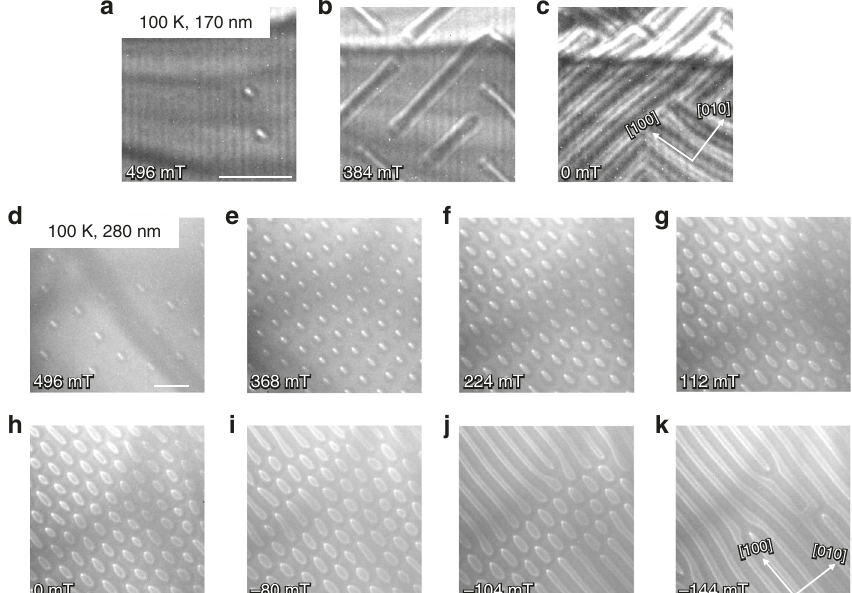
Fig. 4 Elliptical skyrmions at 100 K for two different sample thicknesses. In a – c LTEM measurements in the previously investigated sample (170 nm thick) are shown. The fi eld is reduced coming from the ferromagnetic phase, with only a few skyrmions shown in a . In b helices have formed that constitute the ground state at zero fi eld in c . In d – k the sample has a thickness of 280 nm. Starting again at high fi elds ( d ), a dense array of elliptical skyrmions forms ( e ), which persists upon decreasing the fi eld ( f , g ), even down to zero fi eld ( h ) and below ( i ). Finally, at − 104 mT ( j ), the helical phase starts to dominate. At − 144 mT in k , the helical ground state is restored. The scale bars correspond to 500